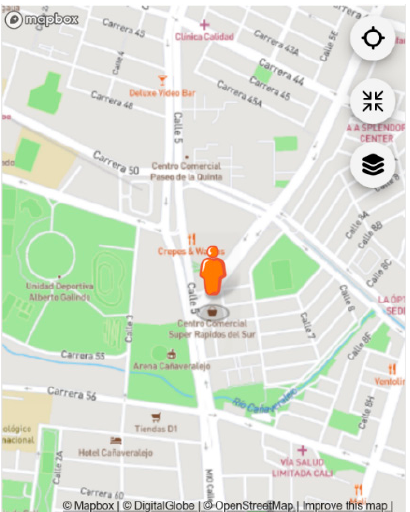
Figure 5. Map-reading task T1 (identify a location on the map) with the Mapbox Streets base map.